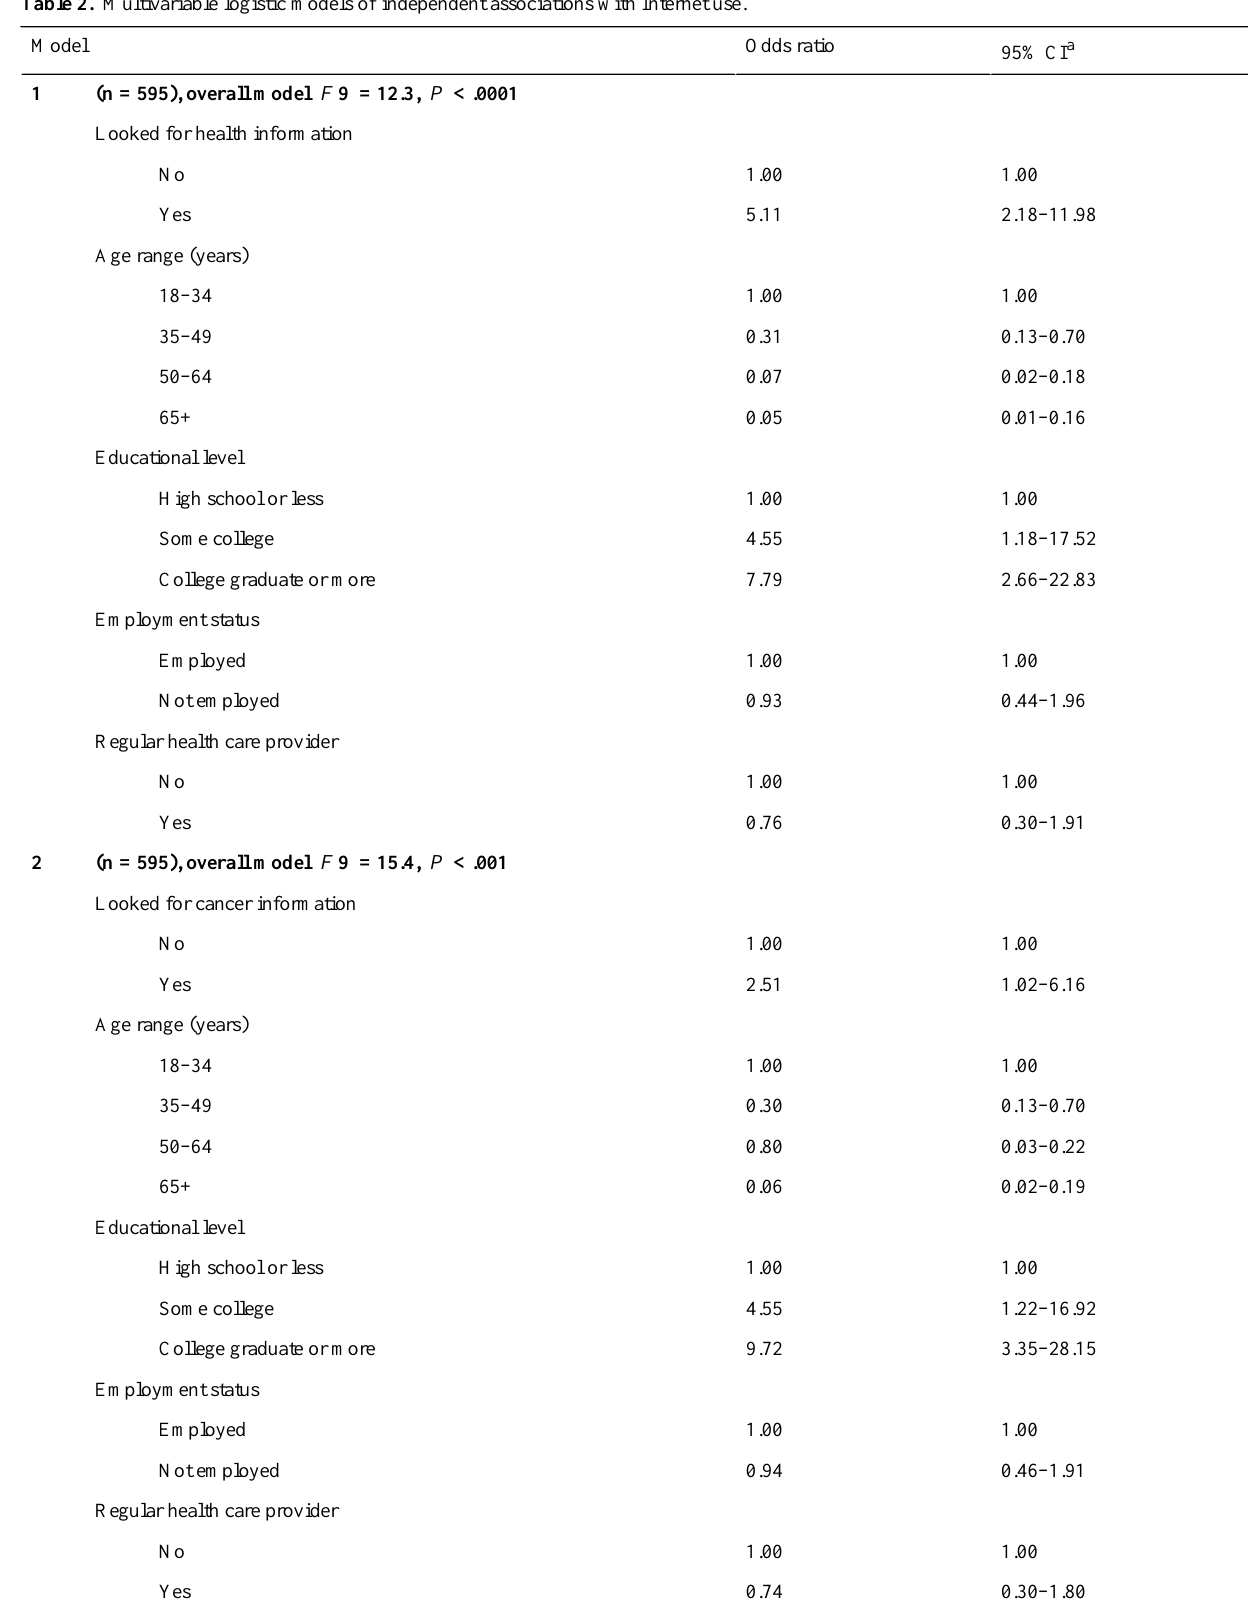
Table 2. Multivariable logistic models of independent associations with Internet